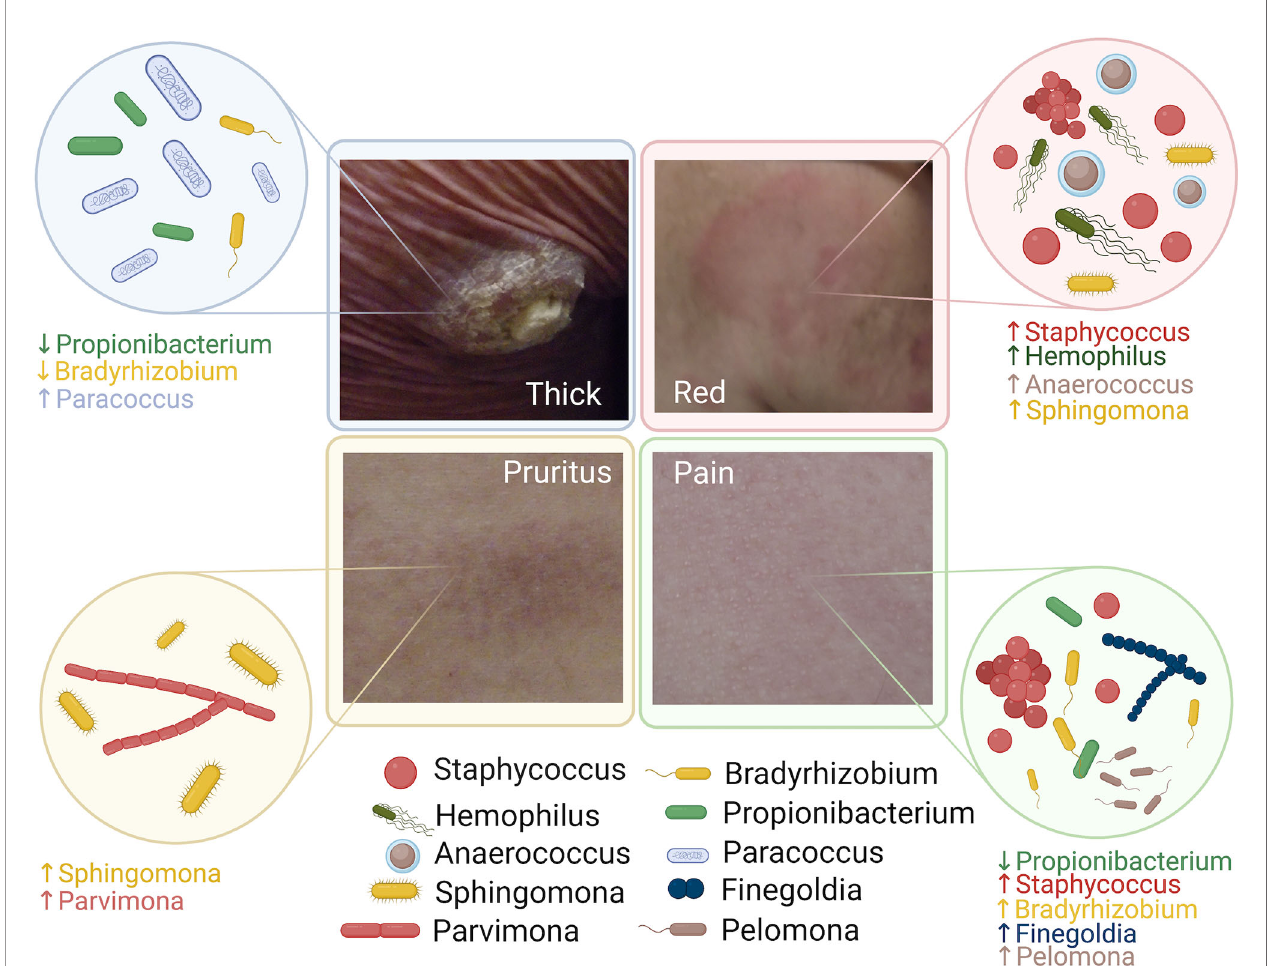
FIGURE 5 | Summary of the microbiota alteration associated with disease phenotype in patients with Mycosis